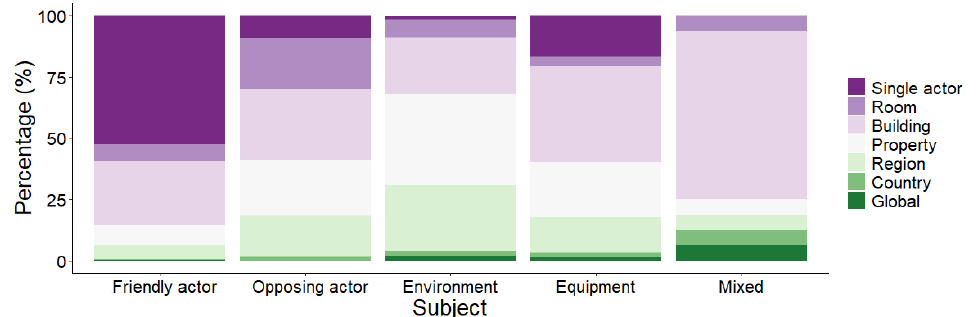
Figure 40. Deployment distribution between subject and scale of the goal